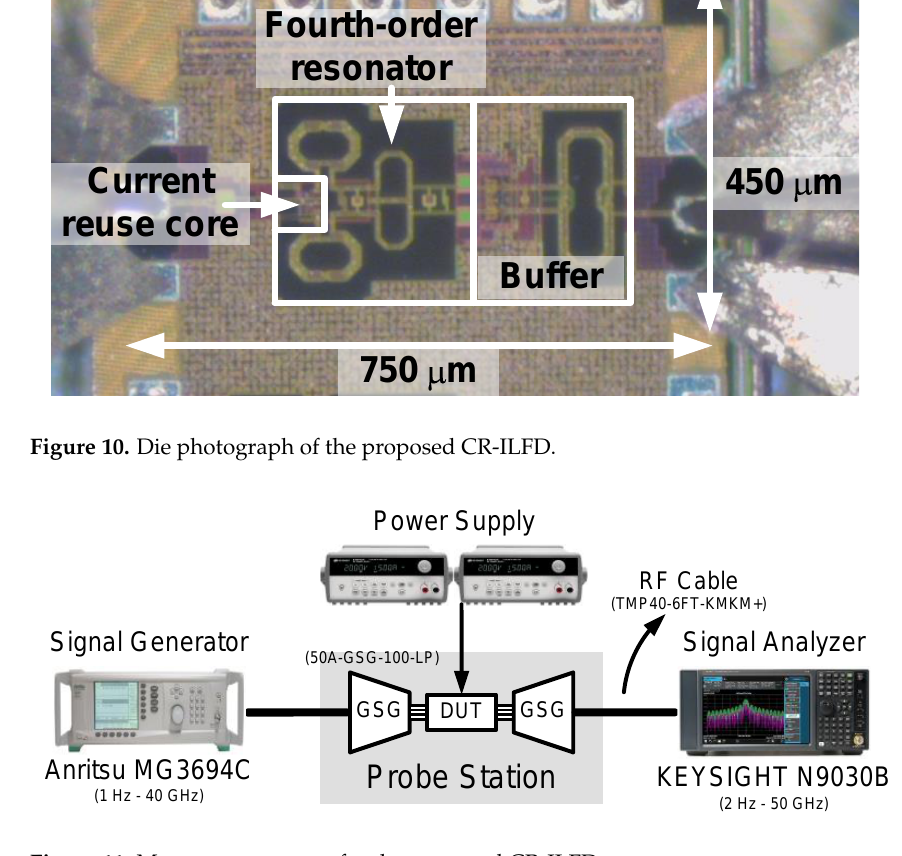
Figure 11. Measurement setup for the proposed CR-ILFD.